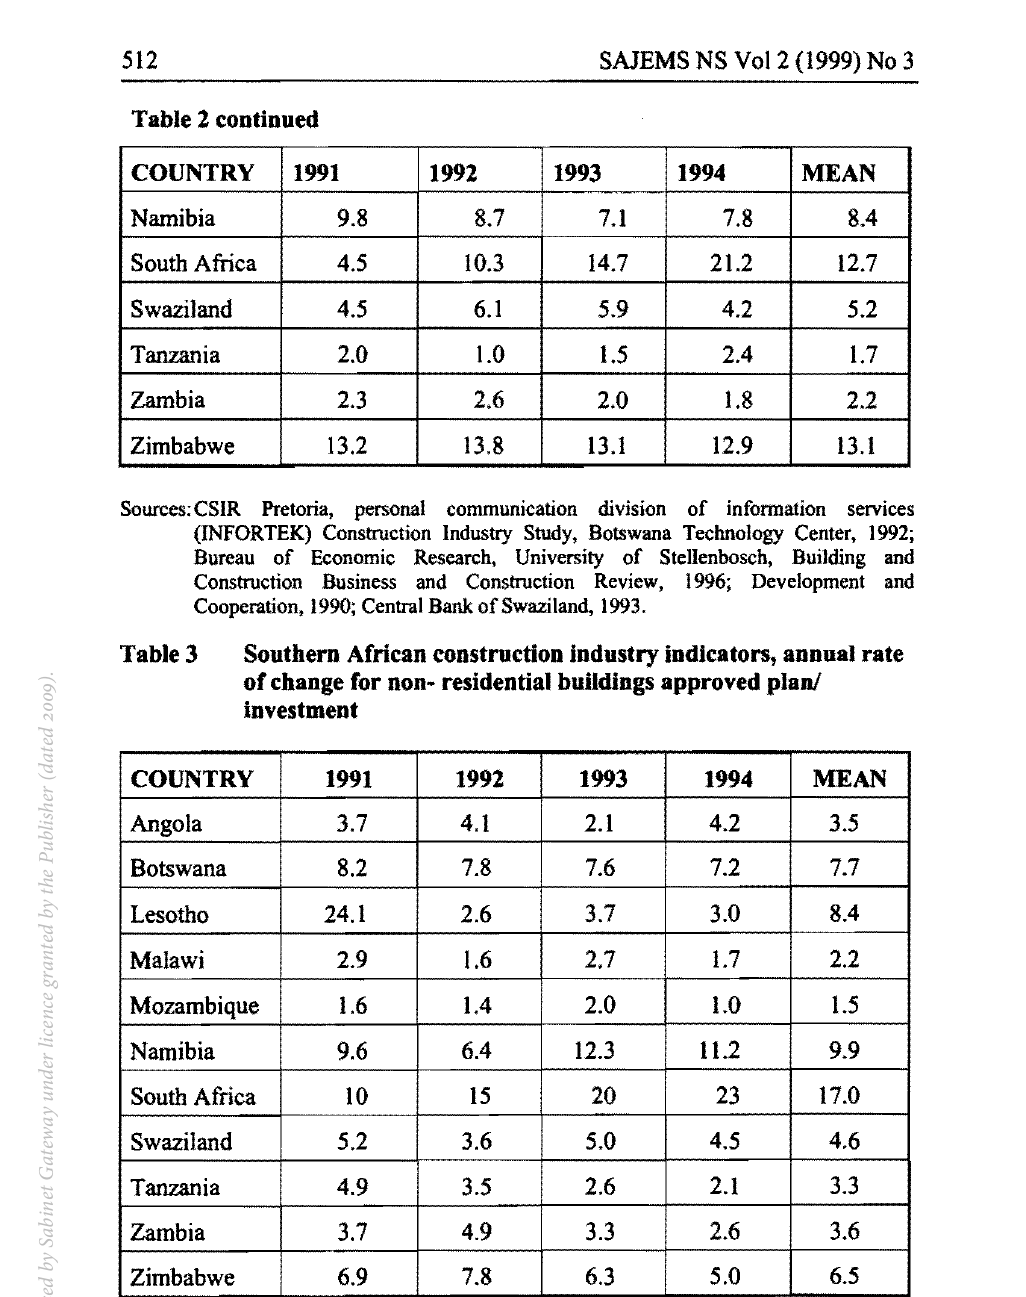
Southern African construction industry indicators, annual rate of change for non- residential buildings approved